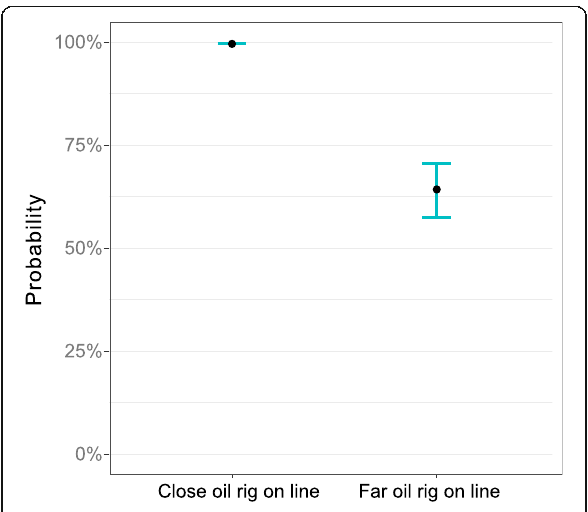
Fig. 9 Predicted probabilities of choosing the close oil rig to receive more damage. Bars represent 95% confidence intervals. Accurate interpretation would be to choose the close oil rig 100% of the